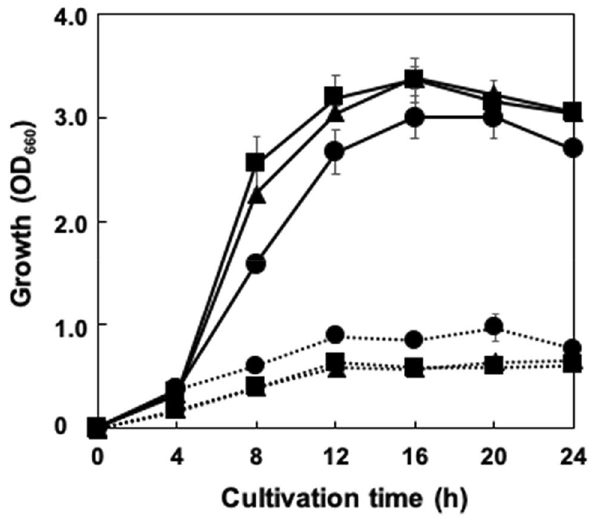
Figure 3. Effect of d-fructose in the culture medium on the growth of the candidate LAB. Each LAB was statically cultivated at 30 °C in 15 ml of MRS medium with (solid lines) or without (dotted lines) d-fructose